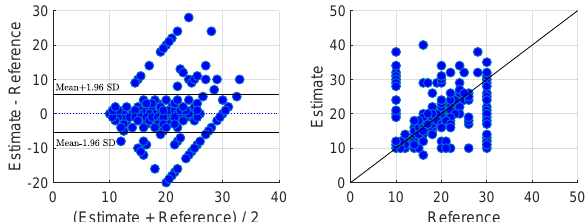
Figure 7. Bland–Altman plot and correlation plot for all the subjects and settings in Dataset B. Reference indicates the RR estimated with the impedance pneumography, whereas estimate indicates the one estimated using the thermopile array. In the Bland–Altman plot, the blue horizontal line represents the mean bias, whereas the two horizontal black lines indicate the average plus or minus 1.96 · Standard Deviation . The black line in the correlation plot indicates the linear relationship y = x